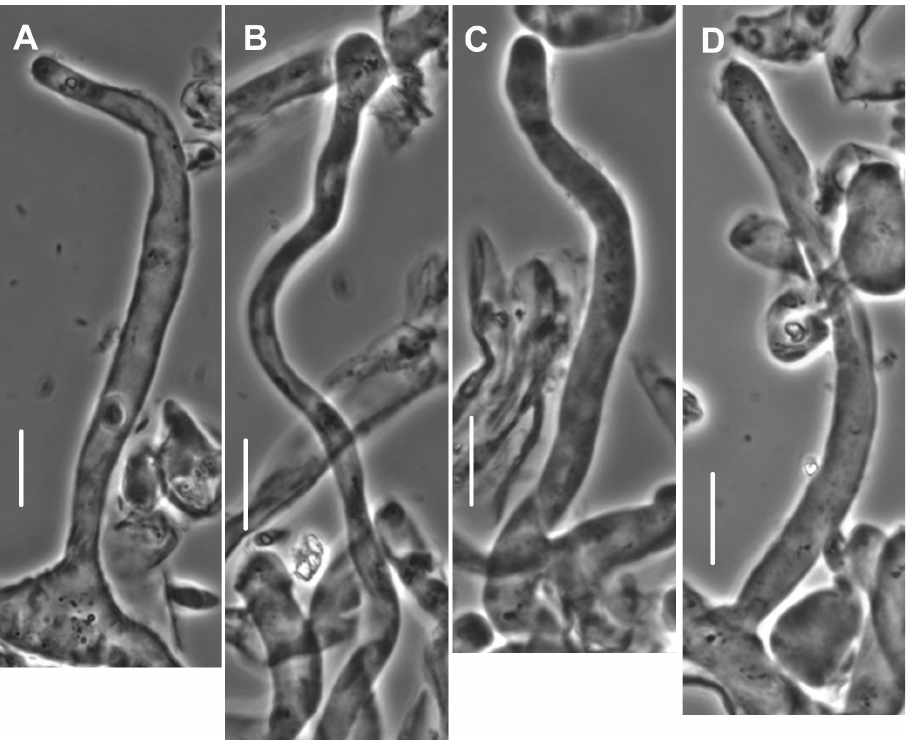
Figure 41. Mycetinis olidus . Pileal hairs. Standard bars = 10 µm. MG 1973 (MICH-F-